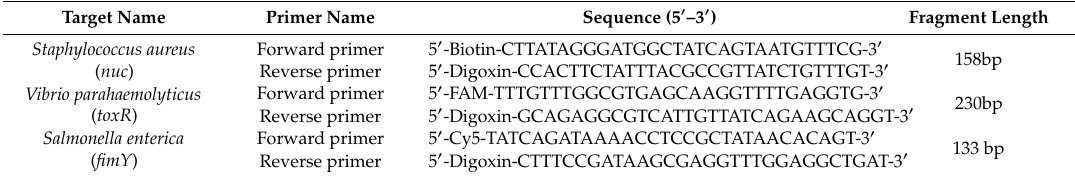
Table 2. Sequences of Staphylococcus aureus , Vibrio parahaemolyticus , and Salmonella enterica recombinase polymerase amplification (RPA)